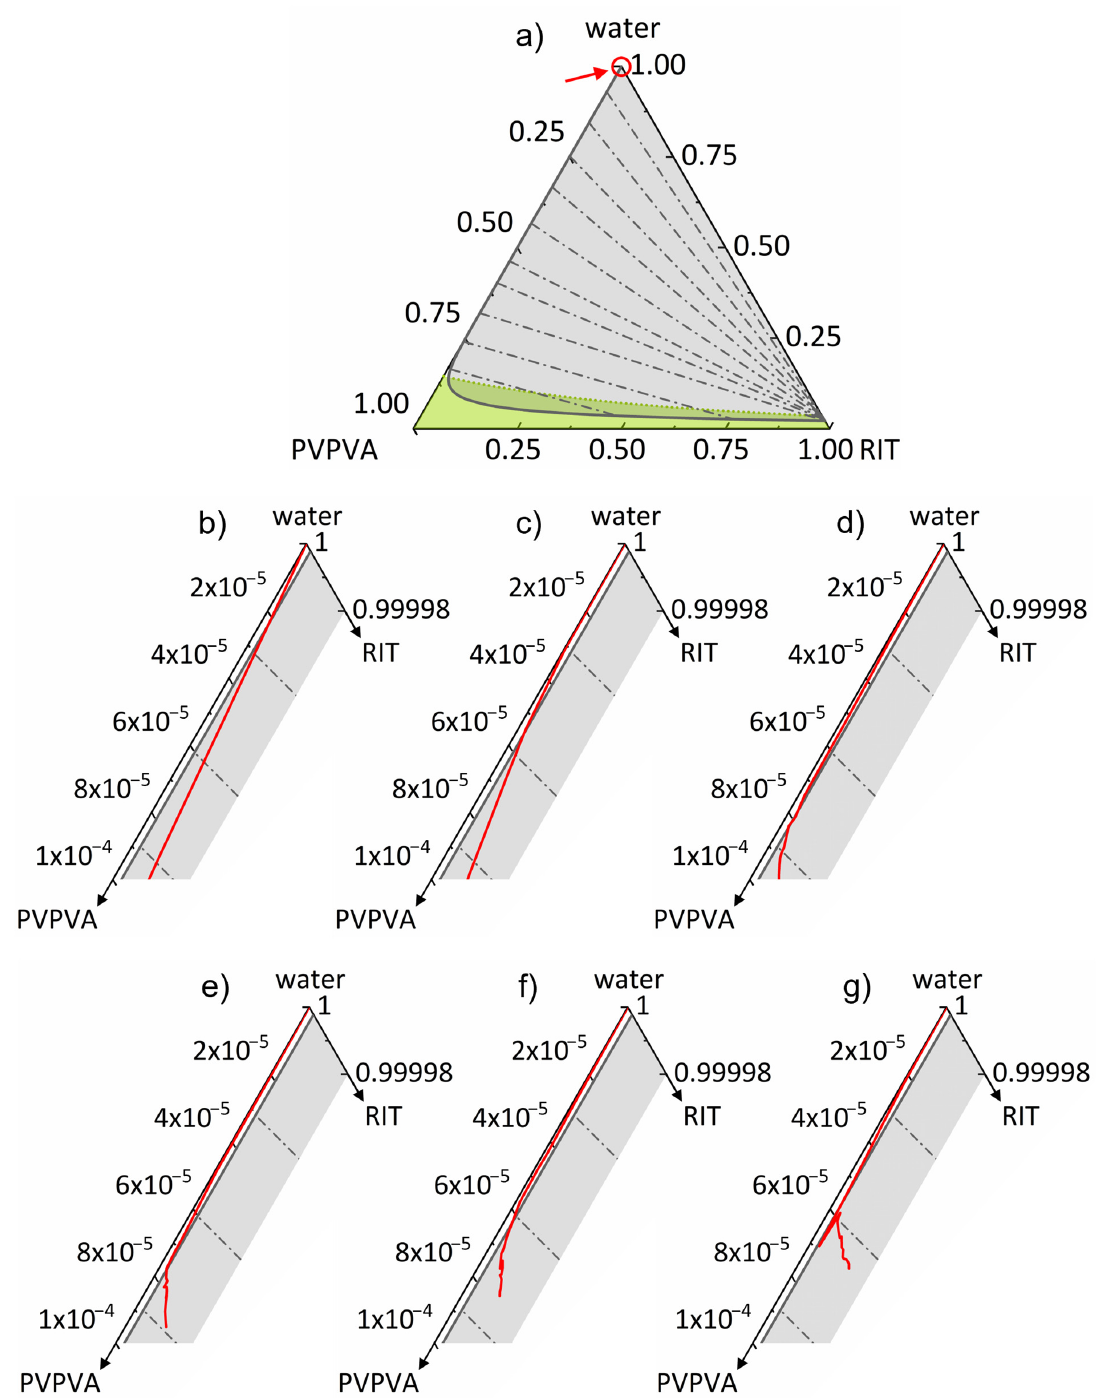
Figure 6. Zoom in the upper left section of the ternary phase diagram of RIT/PVPVA/water (lines in ( a ) are equal to Figure 2) at 25 °C and 0.1 MPa with the PC-SAFT calculated phase boundary (gray solid line left of the gray area) and tie lines (gray dash-dotted lines). The phase boundary indicates the solubility of amorphous RIT in the water/PVPVA solution. Compositions are given in mass frac- tions and correspond to the release data in Figure 5. Red solid lines are compositions of the dissolu- tion medium during the course of the overall dissolution experiments of ASDs with DLs of ( b ) 10 wt% ( 𝑡 ≤ 20 s), ( c ) 20 wt% ( 𝑡 ≤ 120 s), ( d ) 25 wt% ( 𝑡 ≤ 3600 s), ( e ) 30 wt% ( 𝑡 ≤ 10,800 s), ( f ) 35 wt% ( 𝑡 ≤ 10,800 s), and ( g ) 40 wt% ( 𝑡 ≤ 10,800 s).